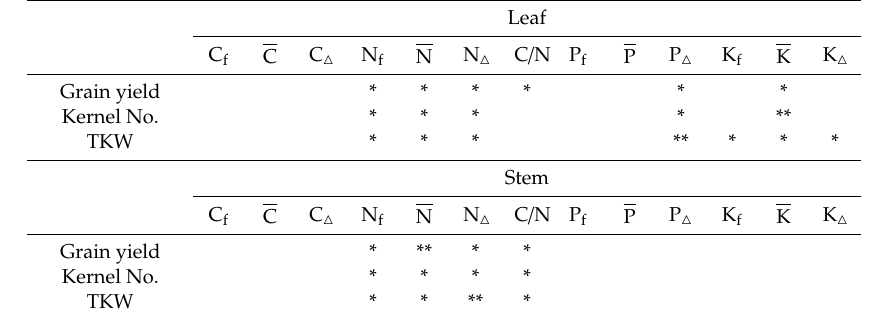
Table4. Thecorrelationanalysisof C,N,P, Kconcentration(%)dynamics inleafandstem post-flowering, grain yield, kernel number (kernel No.), and thousand kernel weight (TKW).